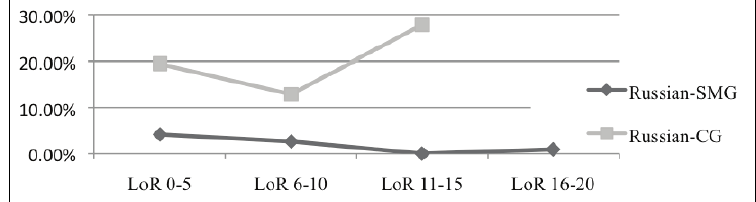
Figure 10: LoR of the participants and non-target test